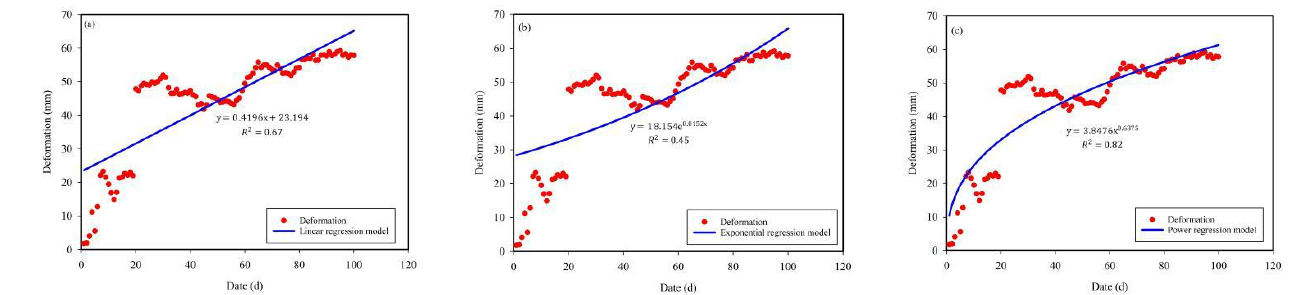
Figure 7. The results of regression analysis in the fourth threshold interval with different regression models. ( a ) Linear regression model; ( b ) exponential regression model; ( c ) power regression model.